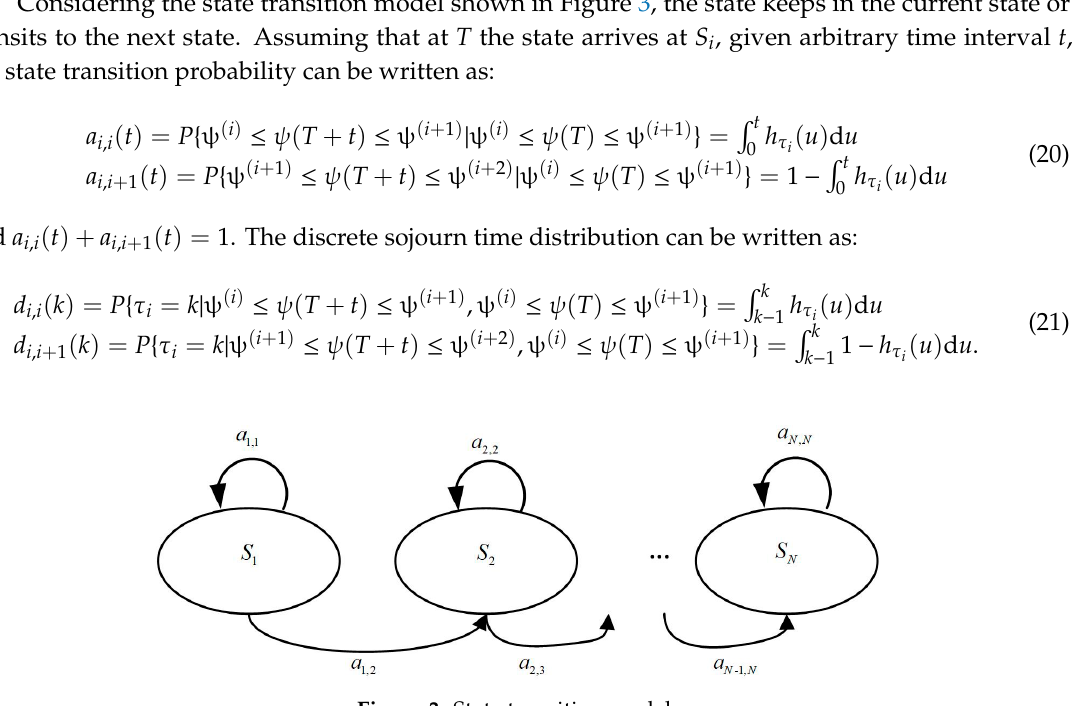
Figure 3. State transition model.